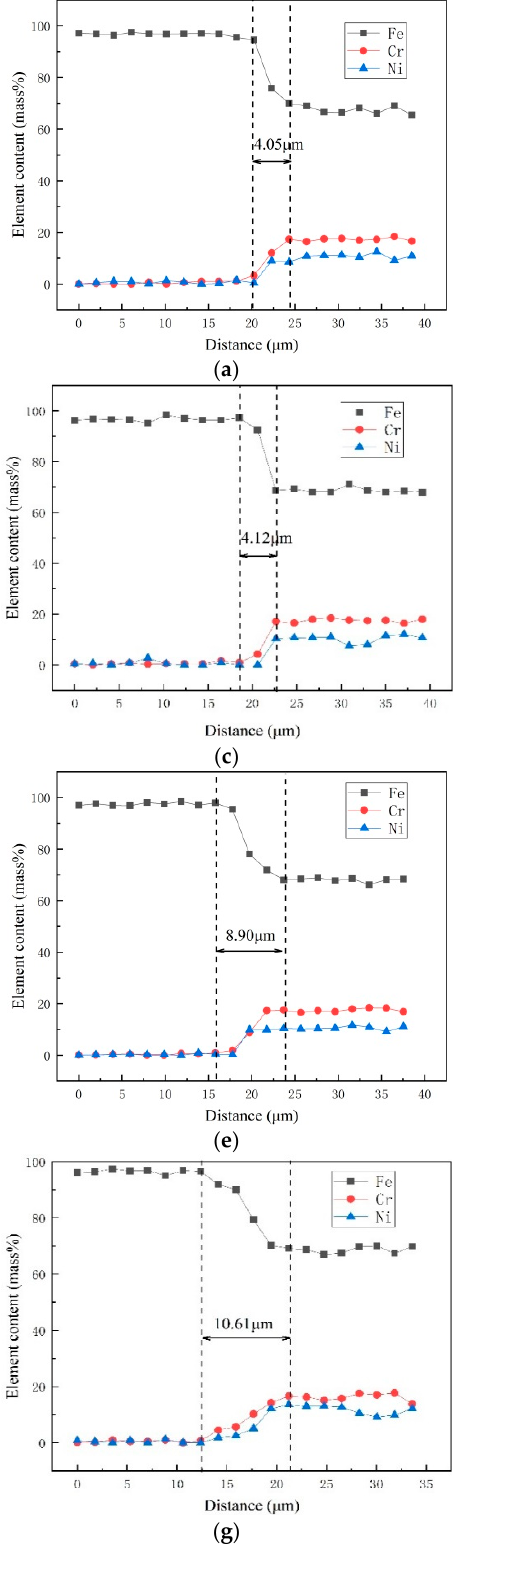
Figure 4. Line analyses of transition zone: ( a , b ) 500 °C; ( c , d ) 600 °C; ( e , f ) 800 °C; ( g , h ) 1000 °C.